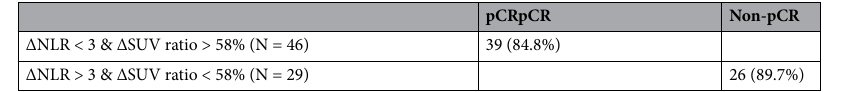
Table 4.. Predictive value of combined ΔNLR and ΔSUV for pCR. pCR pathological complete response, ΔNLR the change of neutrophil–lymphocyte ratio before and after concurrent chemoradiotherapy, ΔSUV ratio the change of maximum standardized uptake value of the esophageal tumor before and after concurrent chemoradiotherapy to pre-chemotherapy.